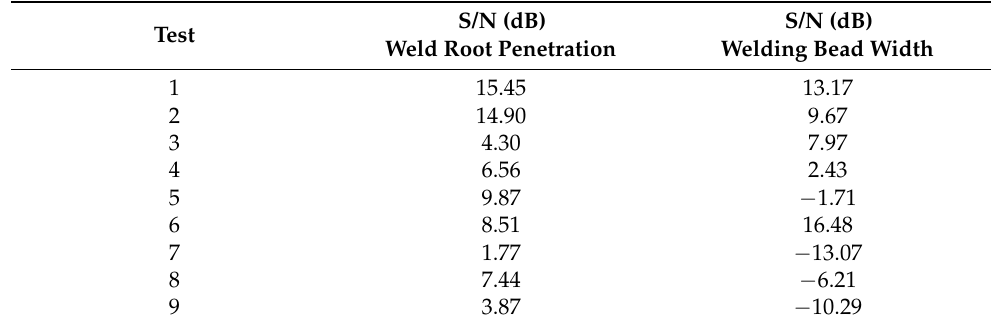
Table 6. S/N ratio (dB) obtained for the penetration and width of the weld bead.